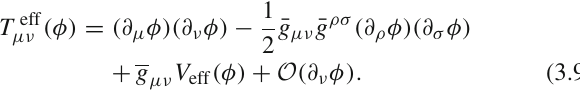
determine that H 2 = (constant) V eff . 5 In the presence of the GB-term, the Hubble constant is determined only by V eff